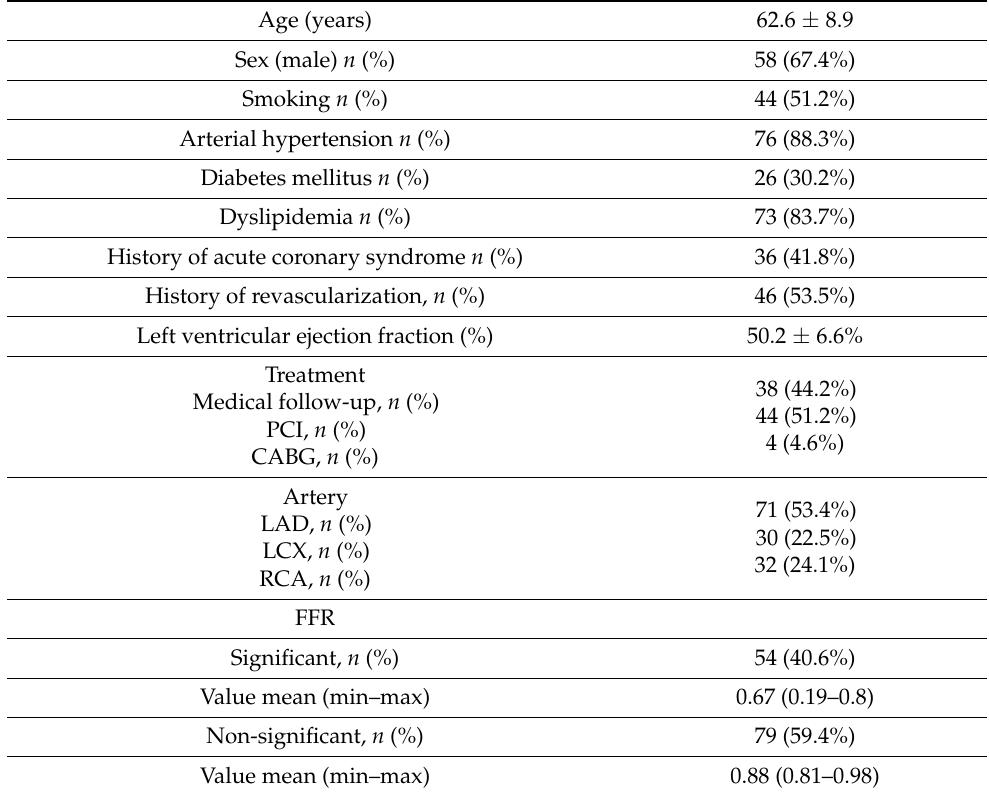
Table 1. The general characteristics of the cohort ( n = 86 subjects) and lesions ( n = 133)